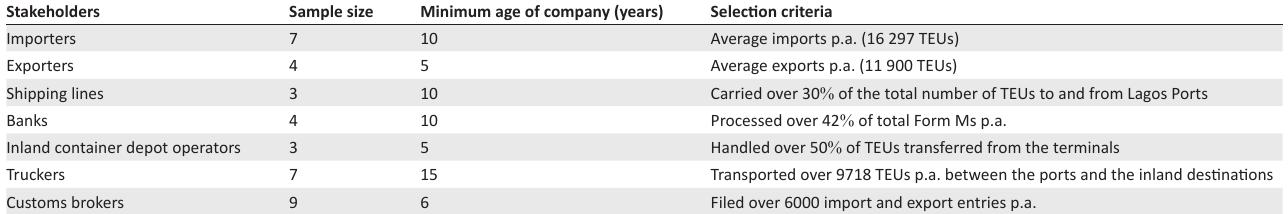
TABLE 1-A1: Stakeholders and selection criteria for the purposive interviews.